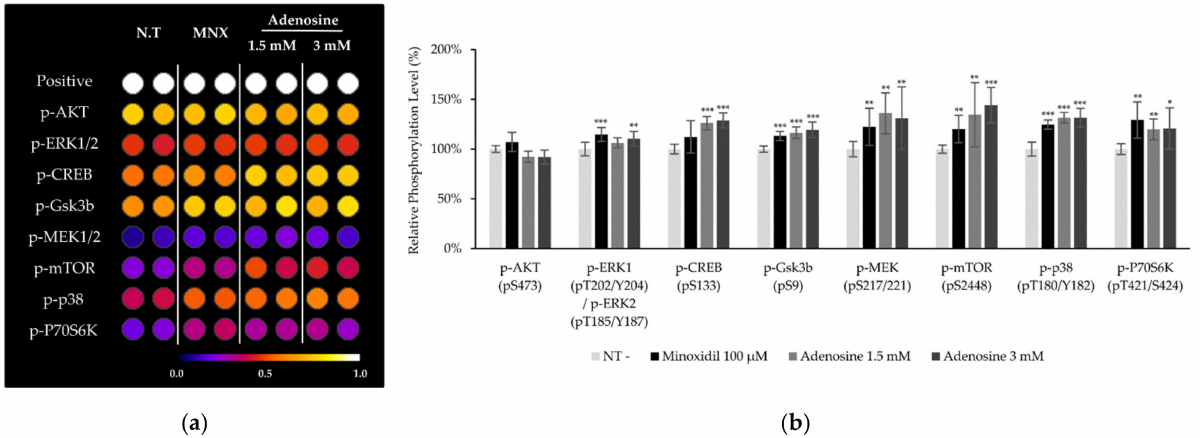
Figure 4. Adenosine enhanced protein phosphorylation and activated MAP kinases in human dermal papilla cells. ( a ) The phosphorylation of proteins including MAP kinases after 10 min treatment of adenosine was investigated. Seventeen proteins were analyzed and eight proteins are displayed. ( b ) Data were quantitated. Minoxidil was used as a positive control. The data represent the means